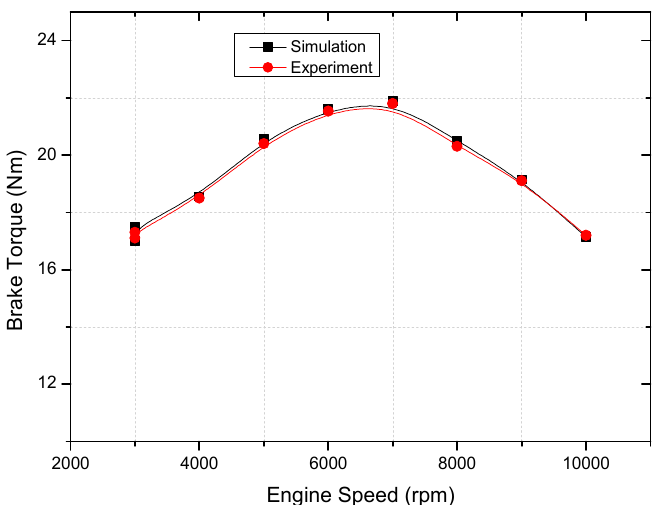
Figure 5. Air mass flow versus engine speed. Errors in measurement of the engine brake torque and power were restricted by support from the accurate ratio between air-fuel and engine friction. On the other hand, the m parameter in Equation (3) is used as a key in reducing errors. Figure 6 shows the results for brake torque indicator in both cases (simulation and experiment). The numerical simulation values are similar with experimental data at each velocity. Interestingly, at 7000 rpm, the brake torque reached the peak at 21.8 Nm. The difference between theoretical and experimental cases was approximately 0.9%.